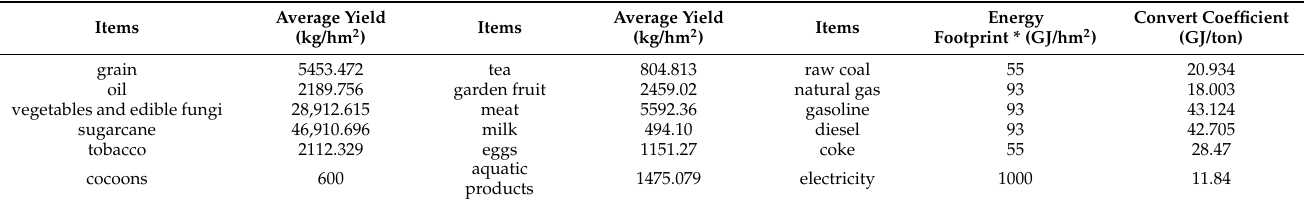
Table 2. Average yield and energy conversion coefficient of “province hectare” in the